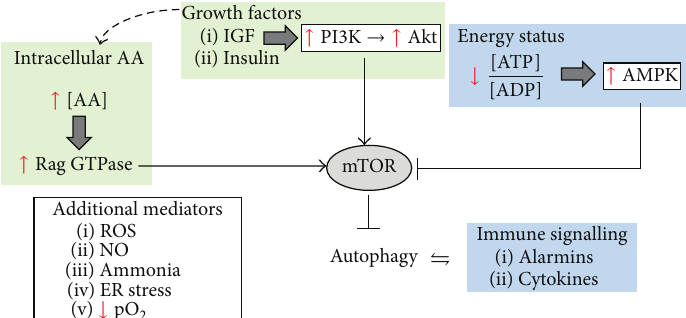
Figure 1: Autophagy plays a key role in energy homeostasis, immune regulation, and a generic stress response to various insults. Growth factor signalling is known to inhibit autophagy directly but may also influence autophagy indirectly, by controlling the cellular import system for AAs. High levels of AAs (in particular, essential AAs such as the BCAA, leucine) also inhibit autophagy through activation of mTOR. In contrast, low energy status upregulates AMPK, which in turn inhibits mTOR, resulting in an increase in autophagy. Autophagy can also be activatedbyimmuneeffectorsincludingTLR-4activationoralarminsorviacytokinesuchasIl1-bandIFN- 𝛾 .Also,autophagymodulatesthese inflammatory mediators, for example, by degrading the inflammasome. Finally, autophagy as a generic stress response is also upregulated under hypoxic conditions, or in response to oxidative